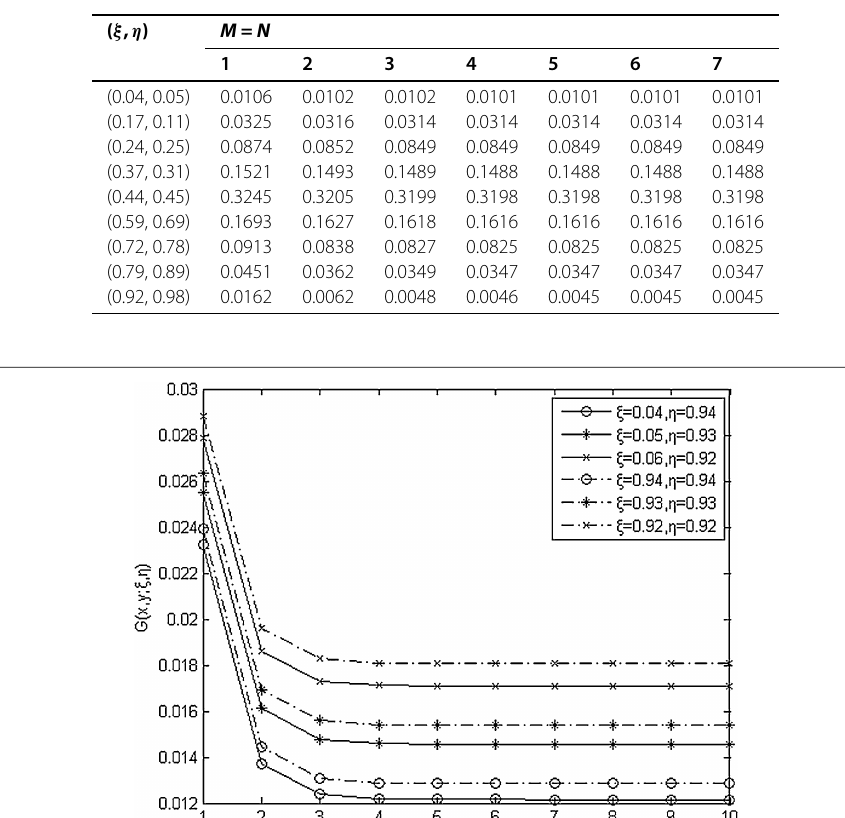
Table 1 Convergence procedure of nine selected points